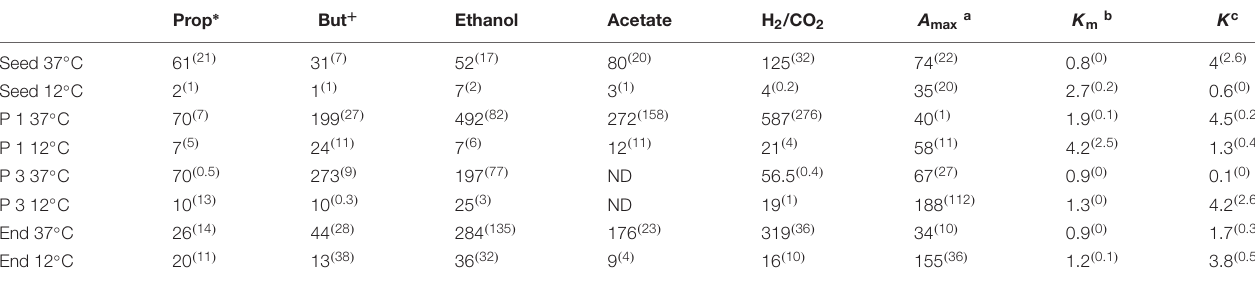
TABLE 4 | Specific Methanogenic Activity (SMA) of reactor sludge throughout the trial at 37 and 12 ◦ C in ml Methane (CH 4 ) g [VSS] − 1 d − 1